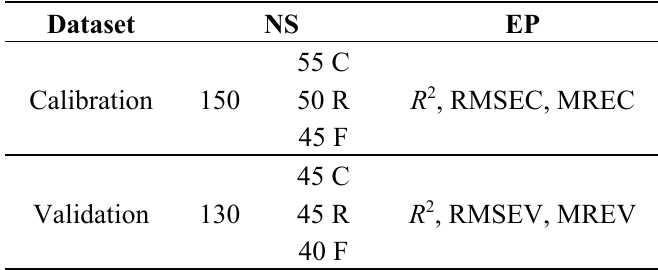
Table 3. Descriptive statistics of the calibration/validation set.